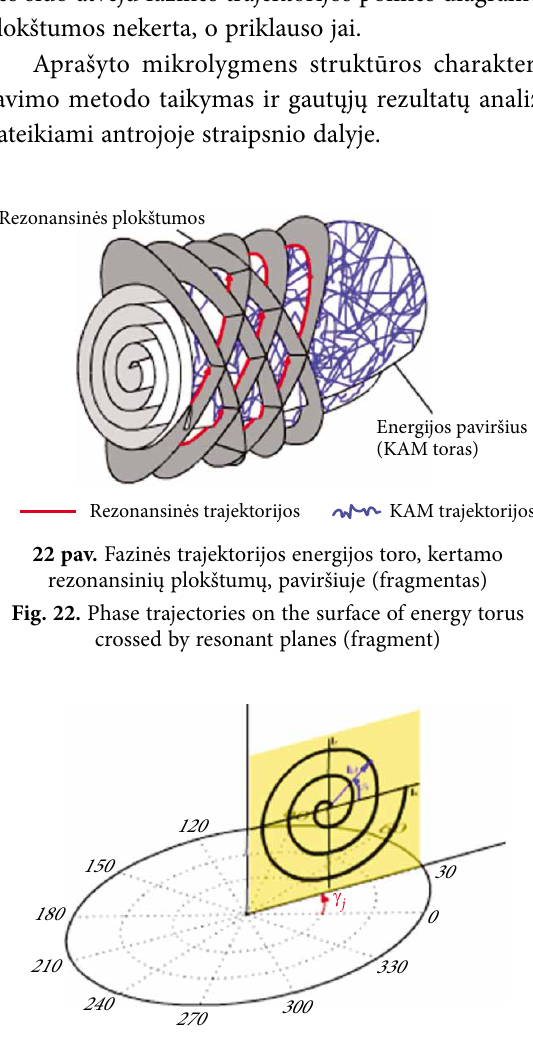
23 pav. Fazinės erdvės globaliosios bifurkacijos plokštuminės diagramos formavimo principas Fig. 23. The principle of forming a planar diagram of the global bifurcation of phase